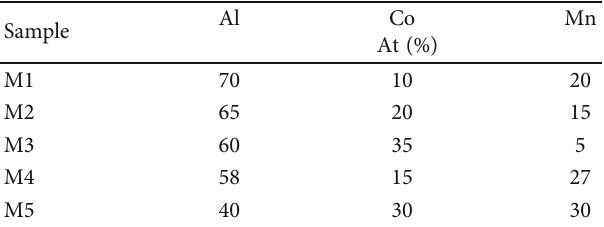
Table 1: Atomic percentages for the Al-based alloys doped with Co-Mn as cast. Sample